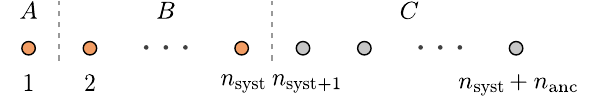
FIG. 5. An illustration of the decomposition of the extended system into three regions A , B , and C as considered in Sec. IV